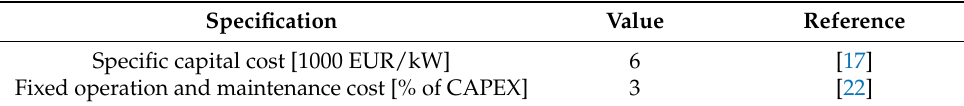
Table 3. Economic parameters assumed for the SOFC unit.